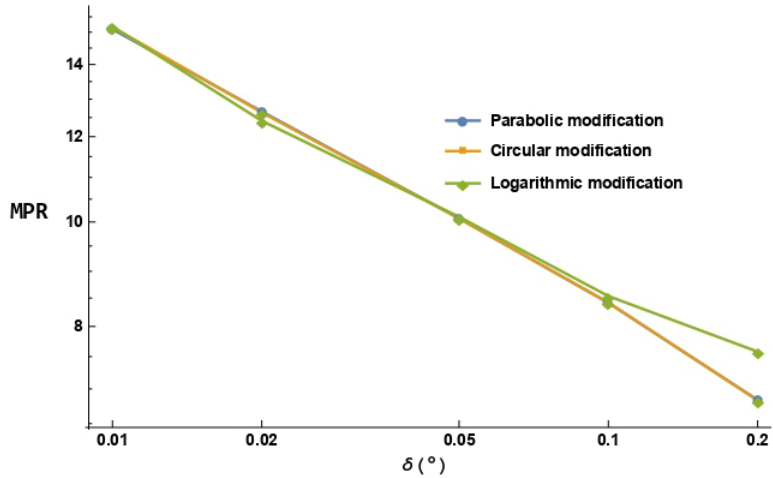
) versus the amount of out-of-plane misalign- 𝑀𝑀𝑃𝑃𝑅𝑅